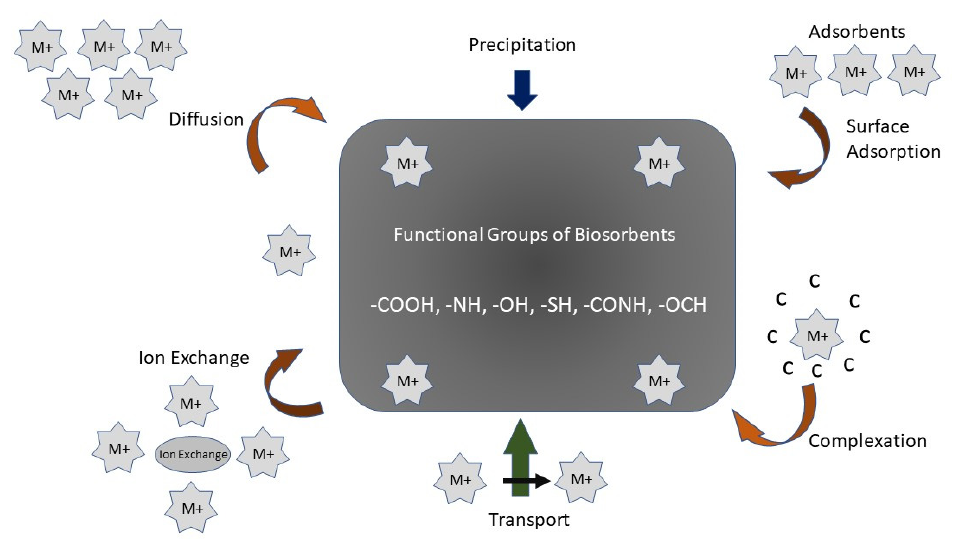
Figure 2. A schematic diagram of the mechanism of biochar/biosorbent to remediate